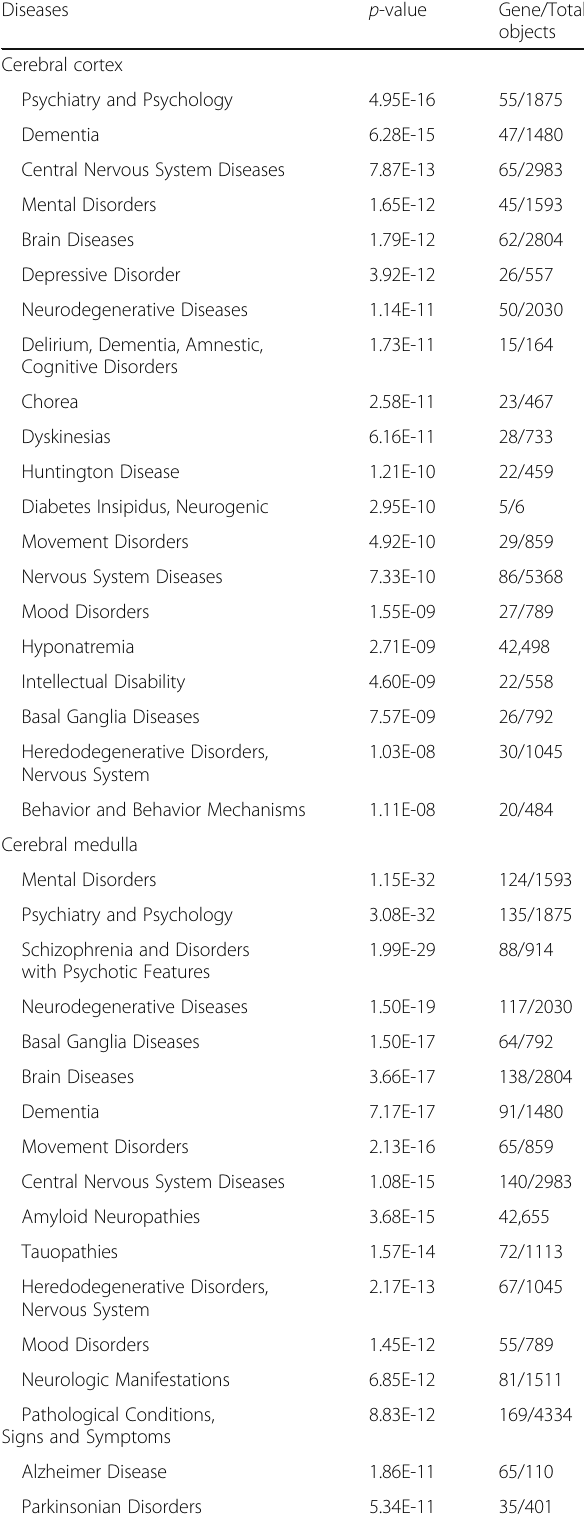
Table 1 Top 20 diseases affected by EA stimulation at ST36 in brain tissues